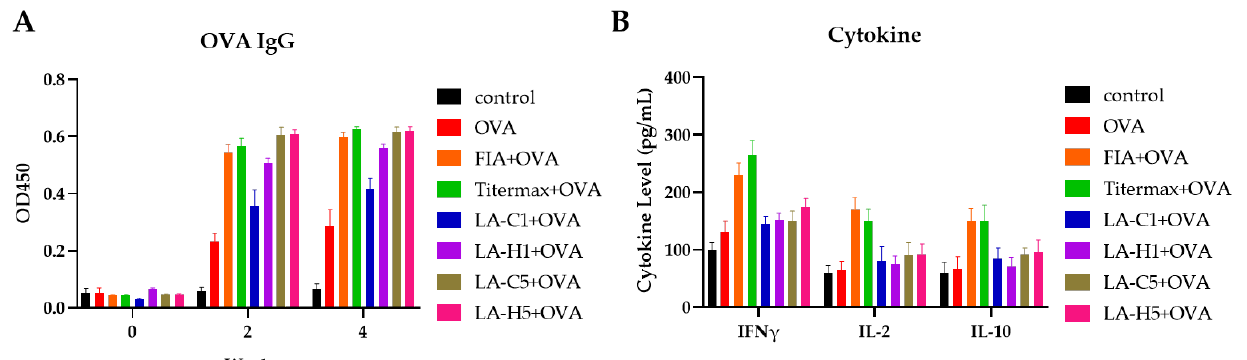
Figure 2. Antibody and cytokine stimulation of vaccinated mice. ( A ) Antibody titer of OVA-induced IgG. p > 0.5 (compared with control) ( B ) Cytokine level of IFN γ , IL-2, and IL-10 from vaccinated mice splenocytes incubated for 48 h. p > 0.5 (compared with control). Control: no vaccination. OVA: ovalbumin. FIA+OVA: Freud’s incomplete adjuvant with OVA. Titermax+OVA; Titermax adjuvant with OVA. LA-C1(0.1 U), LA-H1(0.1 U), LA-C5(0.5 U), LA-H5(0.5 U). LA-C: LA particles treated with HPH. LA-H: LA particles treated with HPH with addition of trehalose and emulsifiers. Data are presented as the mean ± SEM and determined by one-way ANOVA using Tukey’s posttest.